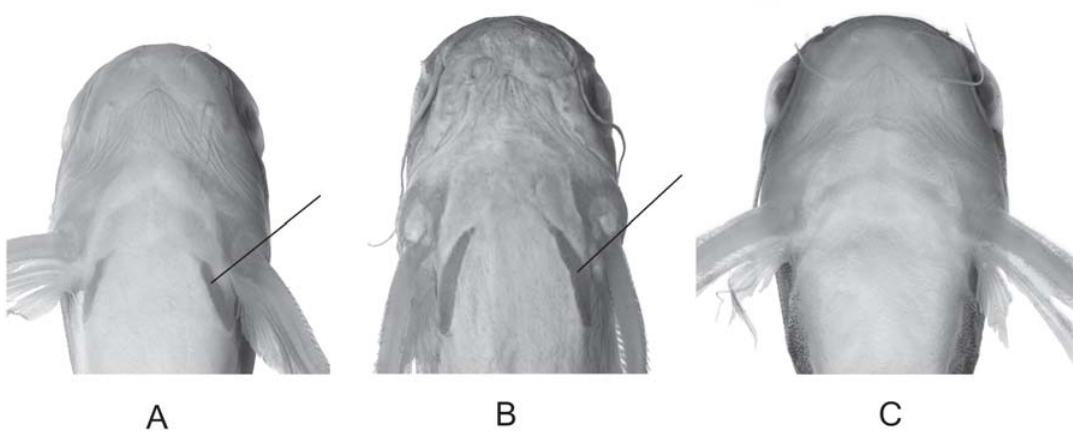
Fig. 1. Ventral view of anterior portion of body of (A) Auchenipterichthys coracoideus , ANSP 178446, 94 mm SL; (B) A. thoracatus, FMNH 57798, 89 mm SL; and (C) A. longimanus , INHS 61570, 67 mm SL; showing different degrees of exposure of coracoid in that region. Line points to exposed